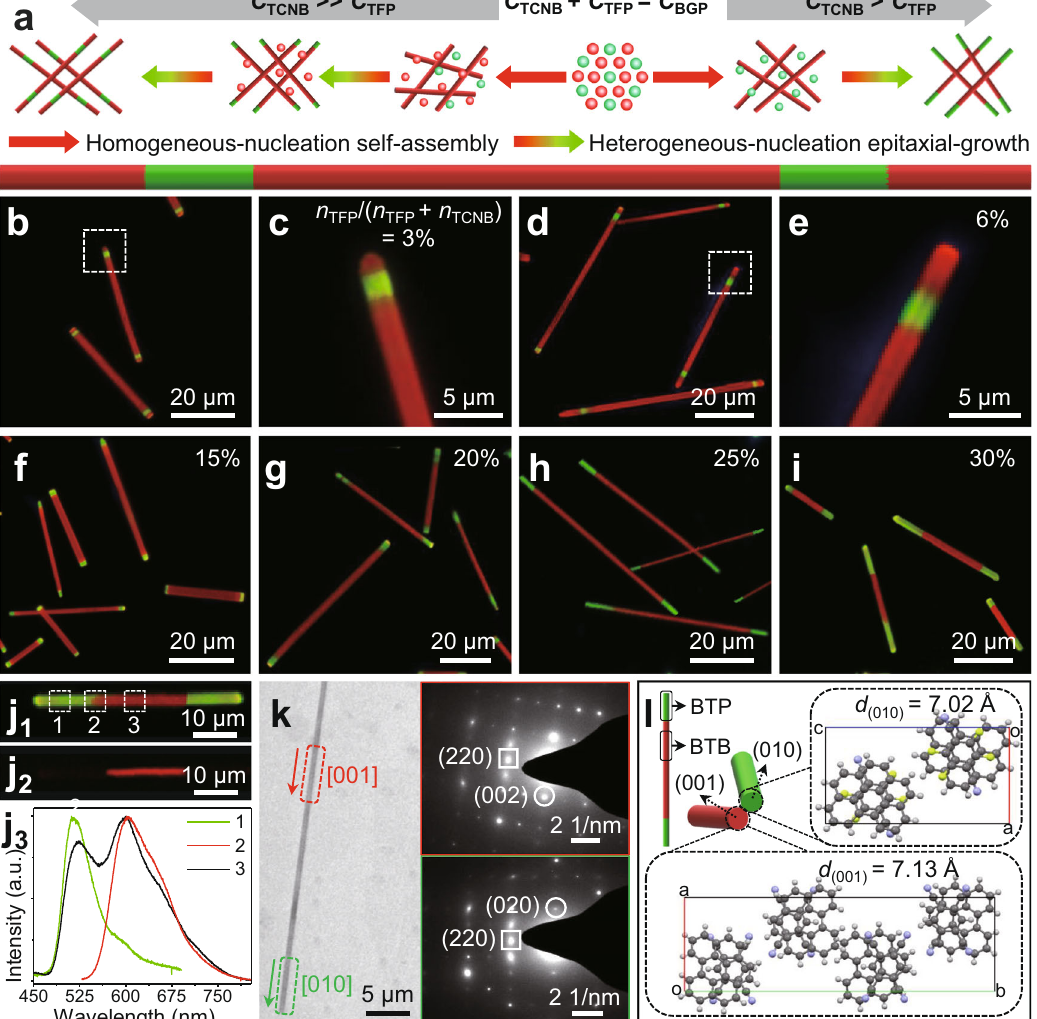
Fig. 4 Segmented organic microwires with tunable multiblock structure. a The longitudinal epitaxial-growth mode for the segmented organic heterostructure microwires. b – e FM images of organic quintuple-block microwires prepared with the acceptor molecular ratio η TFP of b , c 3% and d , e 6%. f – i FM images of organic triple-block microwires prepared with the acceptor molecular ratio η TFP of f 15%, g 20%, h 25%, and i 30%. The scale bars of b , d , f – i and c , e are 20 and 5 μ m, respectively. j FM images of one typical organic triple-block microwire with ( j 1 ) UV-light and ( j 2 ) green-light excitation; and ( j 3 ) the spatially resolved PL spectra corresponding to different locations marked domains in ( j 1 ). k TEM image of one typical organic triple-block microwire with a scale bar of 5 μ m. SAED patterns at the right-upper and the right-below insets collected from the centre part (marked in red gridlines) and the end part (marked in green gridlines) in triple-block microwire, respectively. l Molecular arrangement and orientation at the junction of multiblock excitation from UV light to green light, which is consistent with that on the end tip of the BTP-BTB-BTP triple-block microwires, implying the formation of segmented structure. As shown in Supplementary Fig. 18, the spatially PL spectra of the end (marked as 1, λ = 515 nm) and the centre (marked as 2, λ = 600 nm) parts are in good consistency with those of BTP and BTB, respectively. And the spatially PL spectrum of the hetero- junction (marked as 3) also exhibits the green emission (515 nm) from the BTP and red emission (600 nm) from BTB. The above results clarify the realisation of the integrated segmented-core/ shell type superstructure. Furthermore, the longitudinal epitaxial- growth process was introduced after quickly adding a saturated supernatant of BTB solution into the above balanced horizontal epitaxial-growth system. Then, the segmented-core/shell type-II organic microwires with two red-emissive BTB block epitaxially growing at the tips of segmented-core/shell type-I microwires were obtained (Fig. 5b). Interestingly, the segmented-core/shell